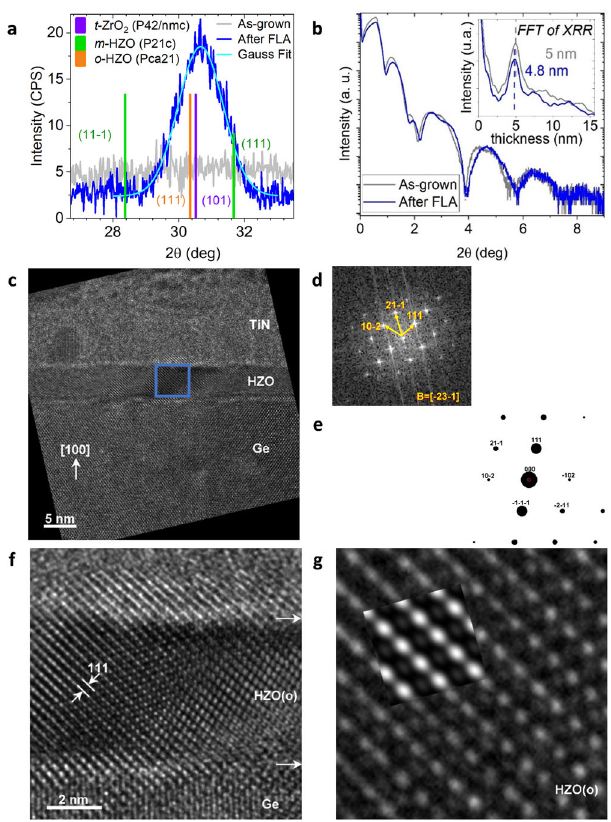
Fig. 1 Microstructure of 5 nm Hf 0.5 Zr 0.5 O 2 (HZO) thin fi lms on Ge by High Resolution Transmission Electron Microscopy (HRTEM). a Grazing Incidence X-Ray Diffraction (GIXRD) spectra before (gray line, amorphous) and after annealing (blue line), gaussian fi t (cyan line) and reference powder diffraction patterns of tetragonal t- ZrO2, monoclinic m- HZO and orthorhombic o- HZO. b X-Ray Re fl ectometry (XRR) and Fast Fourier Transform (FFT) scan. c High-resolution Transmission Electron Microscopy (HRTEM) image of the Ge/ HZO /TiN heterostructure. d FFT pattern of the crystallite marked by the square in ( c ). e simulation of the FFT in ( d ) assuming Pca2 1 orthorhombic ferroelectric structure along the [-23-1] zone axis. f , g Show the crystallite in detail and an HRTEM simulation with the orthorhombic ferroelectric phase Pca2 1 embedded in the real image in ( g ). A defocus of − 20 was assumed, which is the same as the one used to obtain the experimental real image in ( f